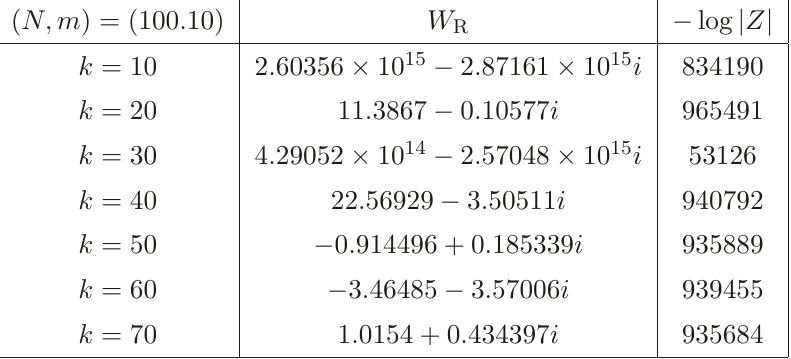
Figure 4 . These figure show that density functions of the real part of saddle point solution for N = 100. The left one is with parameter ( k, m a ) = (10 , 10). The right one is with parameter ( k, m a ) = (150 , 10). The horizontal line means the value of the real part of the eigenvalue. ( N, m ) = (100 . 10)